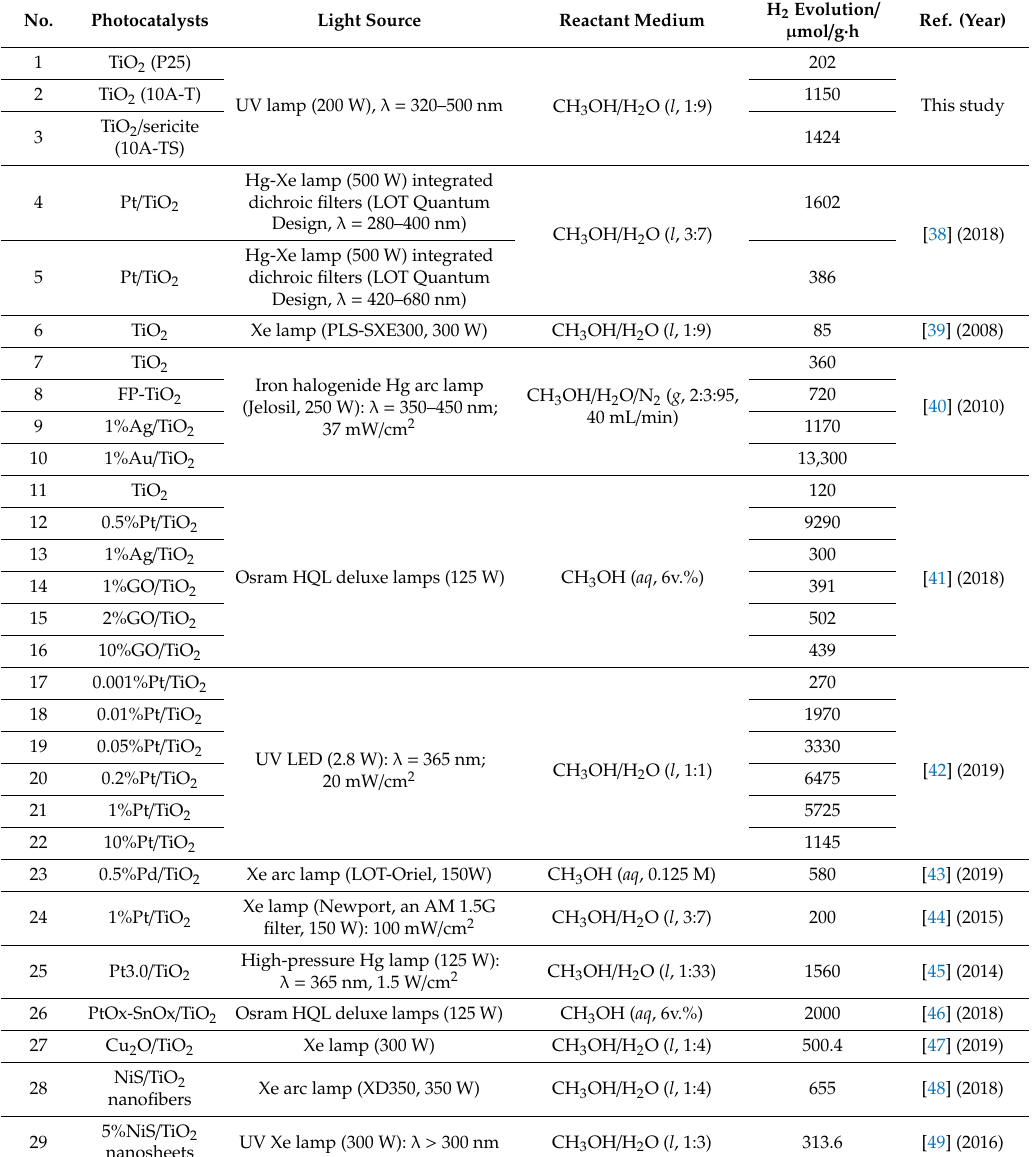
Table 3. The photo-activity performance of various